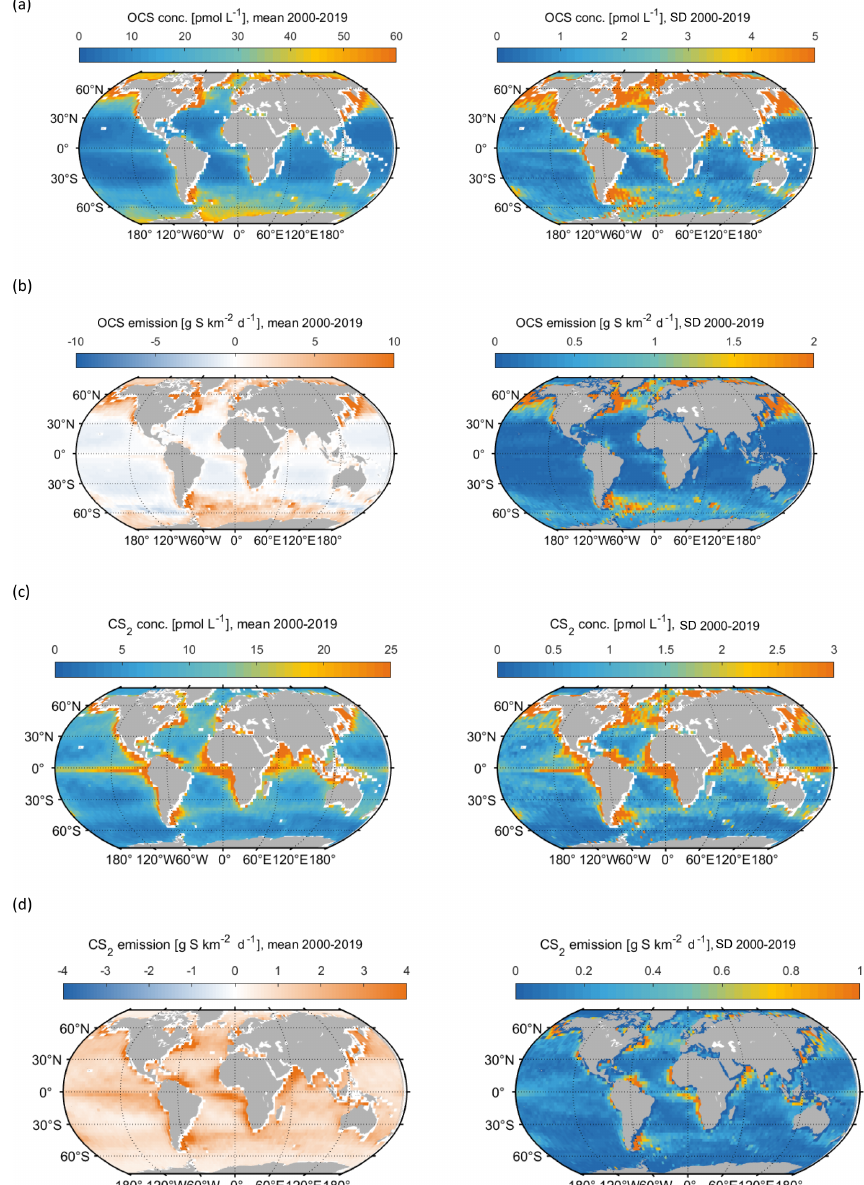
Figure 2. Spatial variation, averaged over the 2000–2019 period, in (a) mean OCS surface concentration (left panel) and standard deviation of annual mean concentrations (right panel), (b) same for OCS emissions, (c) same for CS 2 surface concentration, (d) same for CS 2